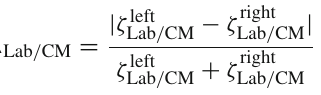
Fig. 4 Determination of the charge (in the unit of e ) for the c - and s -jets coming from ( R + 5